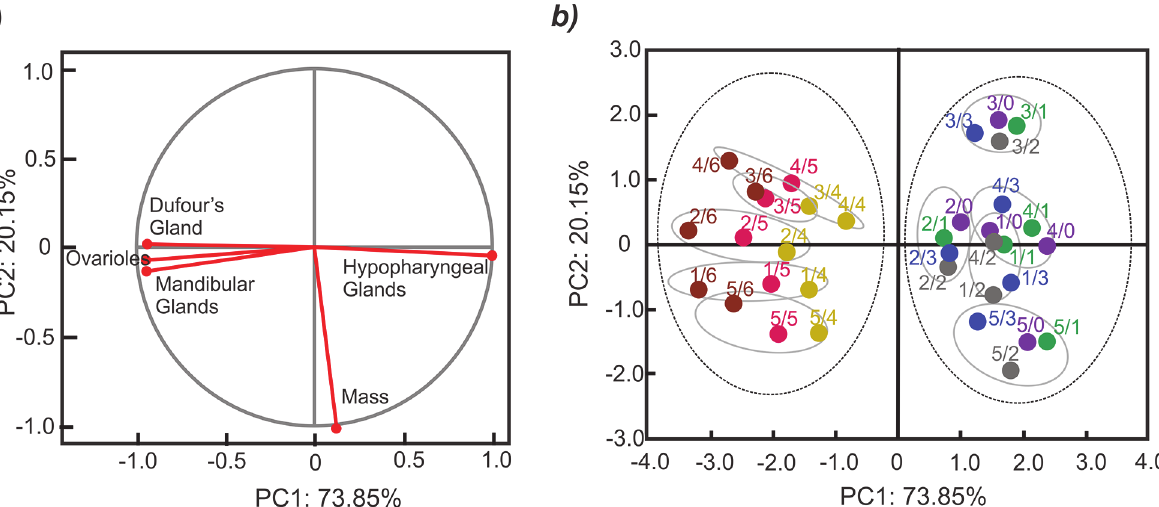
Fig 3. Results of PCA based on the average values of workers ’ ontogenic parameters (body mass, ovariole number, hypopharyngeal gland size, mandibular gland size and Dufour ’ s gland size). Biplot (a) with loading variables showing the correlations of the environmental variables with PC1 and PC2. In the score plot (b) the different colours and numbers describe groups of workers originating from different colonies, reared for different numbers of days in the queenless condition (e.g. number 4/3 indicates workers that originated from the fourth colony and group 3, whereas number 2/0 indicates workers originating from the second colony and group 0). The dotted circles indicate two clusters of workers (rebel and non-rebel), whereas the grey circles indicate sub-clusters of workers from each colony based on their similarity in body